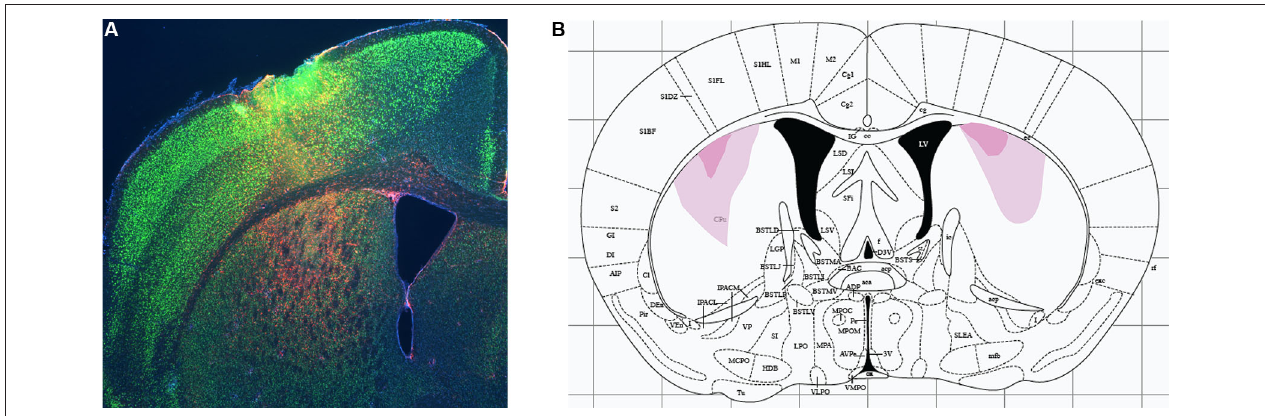
FIGURE 1 | Excitotoxic lesions of dorsomedial striatum. (A) Excitotoxic lesions were produced by stereotaxic infusion of NMDA; control animals received equivalent infusions of saline. Lesions were documented by immunohistochemistry for glial fibrillary acidic protein (GFAP,